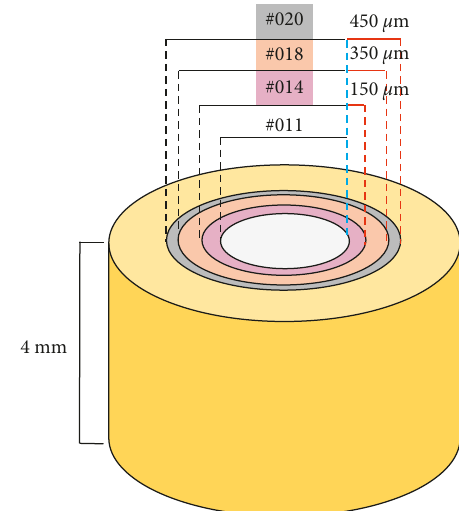
Figure 1: Dentin depth. The white circle represents the root canal prepared with an ISO size #011 bur. Colored circles represent different dentin layers at increasing depths, sampled by incre- menting bur sizes (ISO #014, #018, #020). Red solid lines represent dentin depths covered by each bur, starting from the root canal wall (dashed blue line). Dentin depth (Ø bur Ø root (cid:31) −